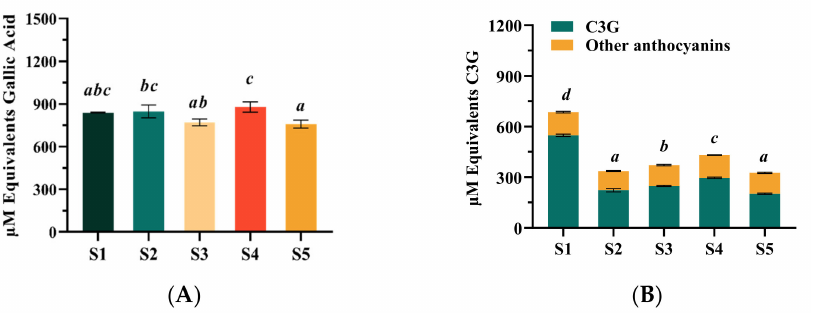
Figure 2. Concentration of anthocyanins and total phenol content (TPC) from five blueberry extracts. ( A ) TPC expressed as gallic acid equivalents ( µ M); ( B ) total anthocyanins content expressed as cyanidin-3-O-glucoside equivalents ( µ M). Different letters were significantly different ( p <